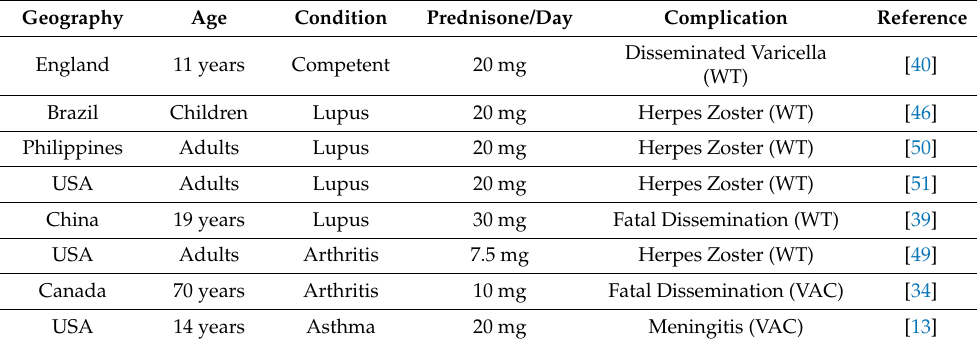
Table 3. Lower dosage prednisone followed by disseminated varicella or zoster.